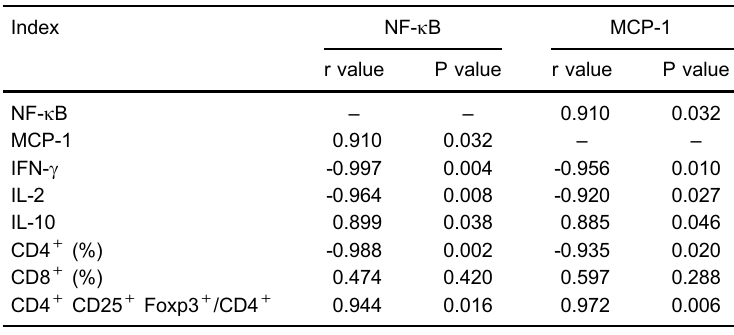
Table 3. Correlations of MCP-1 and NF- k B with immune function in rabbits with induced spinal